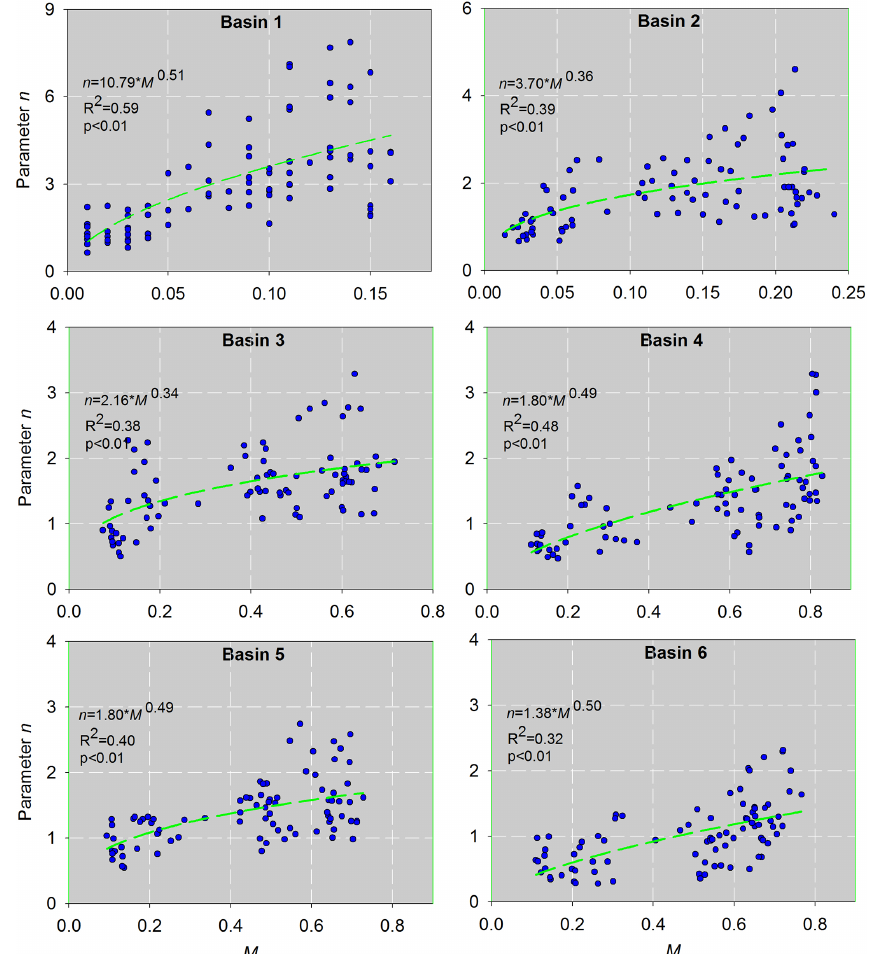
Figure 2. Relationships between the parameter n and the vegetation coverage for each basin on a monthly